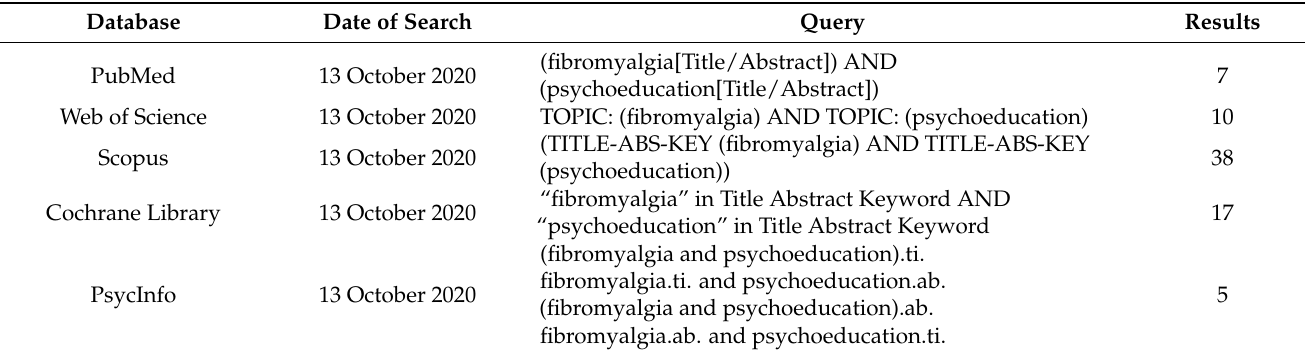
Table 1. Search queries by